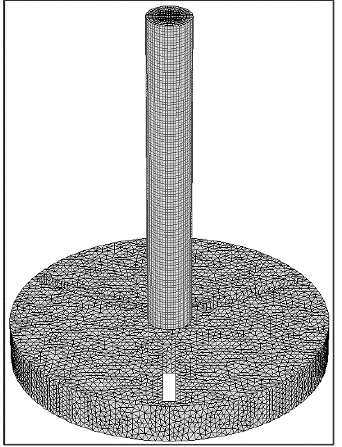
Figure 6. Computational domain mesh.